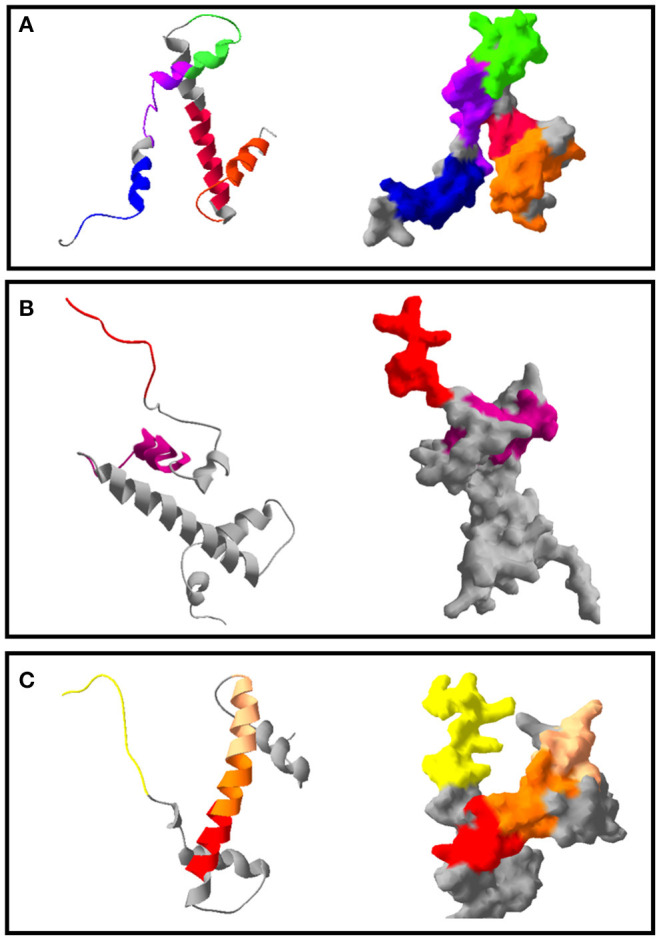
Tridimensional model of Leishmania spp. histones and the position of the immunodominant peptides selected. The colors indicate the different epitope regions of this sequence, which were immunodetected by anti-L. braziliensis IgG on the Spot Synthesis membrane. (A) Ribbon format and solid surface format of the protein HP1. In blue: PH11; in purple: PH17; in pink: PH31; in orange: PH37 and in green: PH61. (B) Ribbon and solid surface format of the protein HP5. In pink: PH190; in red: PH202. (C) Ribbon and solid surface format of the protein HP7. In yellow: PH276; in red: PH290; in orange: PH293; in light pink: PH294.